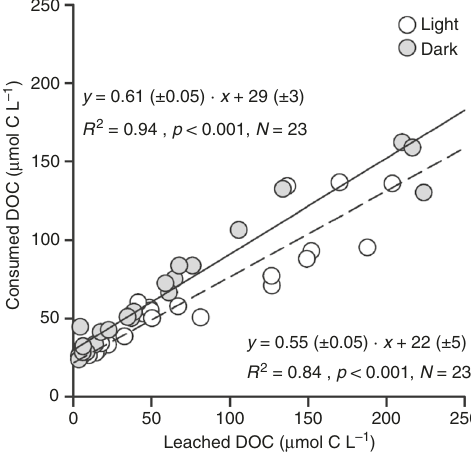
Fig. 4 Relation between DOC consumption by microbes and DOC leaching from plastics. DOC in µ mol C L − 1 . Linear regression equation (Model II) using all data: Y = 0.58 (±0.03) ⋅ X + 45.43 (±3.03) ( R 2 = 0.87; p < 0.001; N = 46). Open circles: irradiated samples; Gray circles: non-irradiated samples. DOC dissolved organic